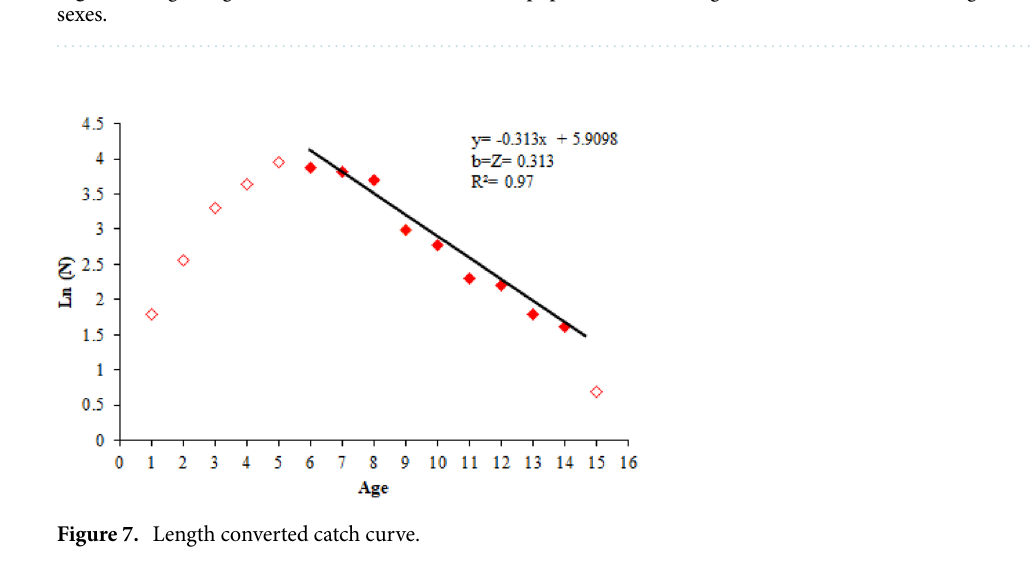
Figure 6. Age-length relations of M. mastacembelus population inhabiting Keban Dam Lake, according to sexes.